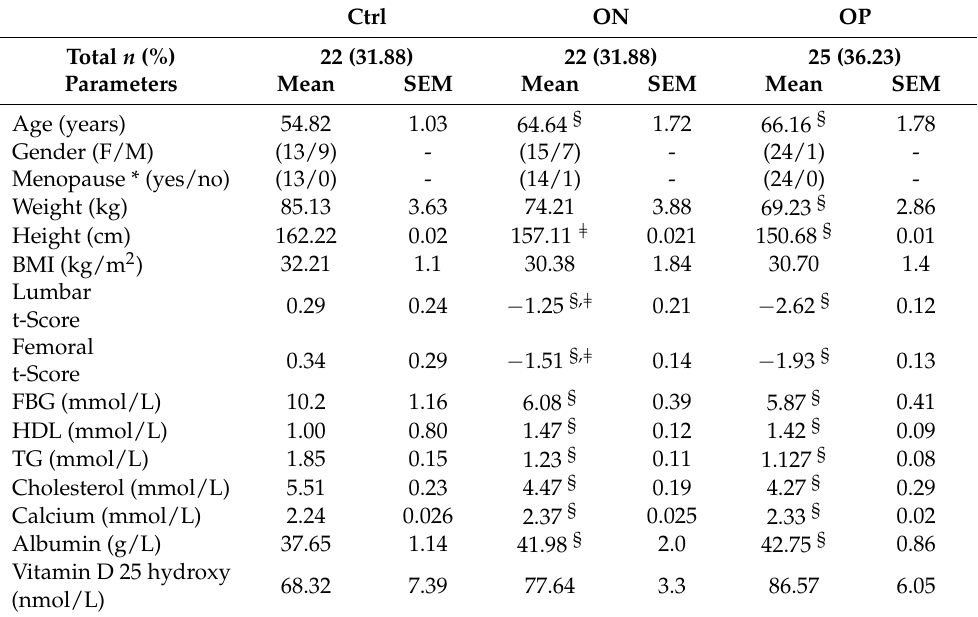
Table 1. Clinical characteristics and demographics of the study population ( n =